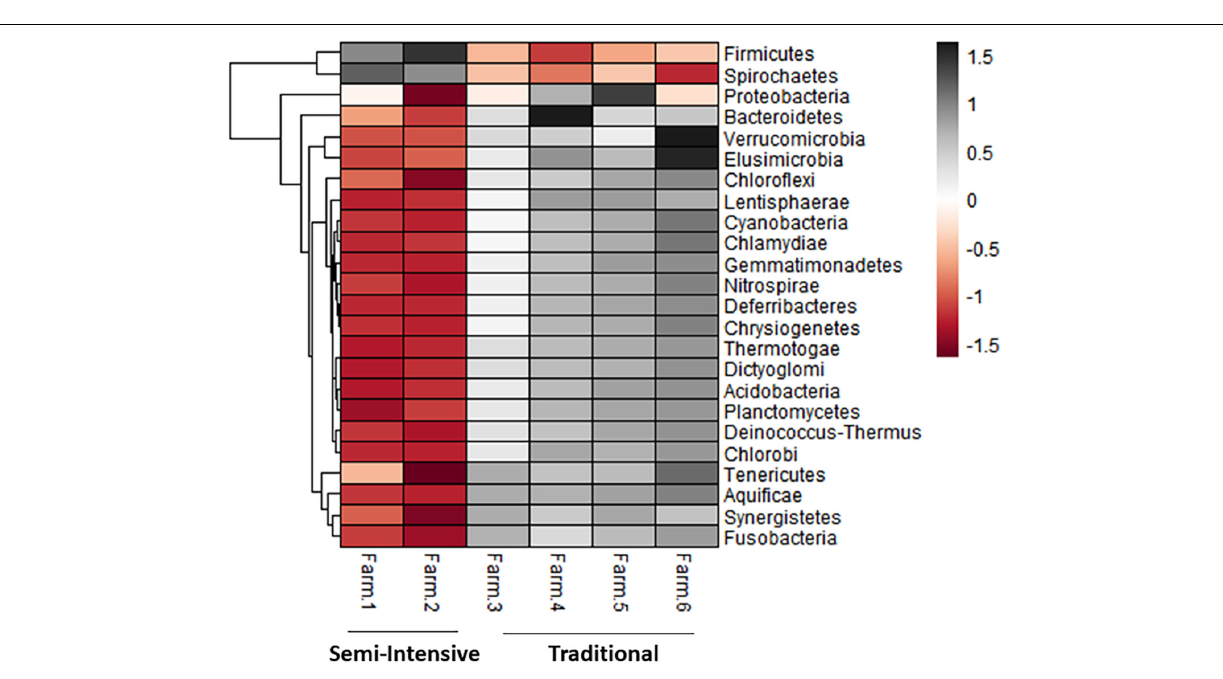
FIGURE 4 | Heatmap showing the differential abundance of bacterial phylum in the fecal microbiota farms from semi-intensive and traditional management systems. The color key relates the heatmap colors to the standard score (z-score), i.e., the deviation from row mean in units of standard deviations above or below the